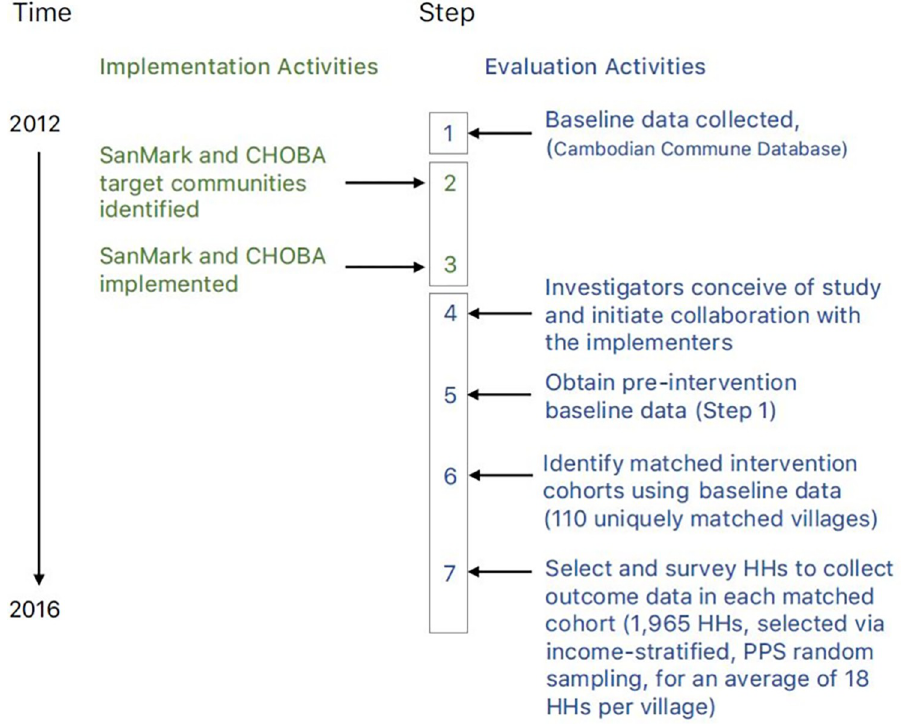
Fig 1. Overview of program implementation & data collection